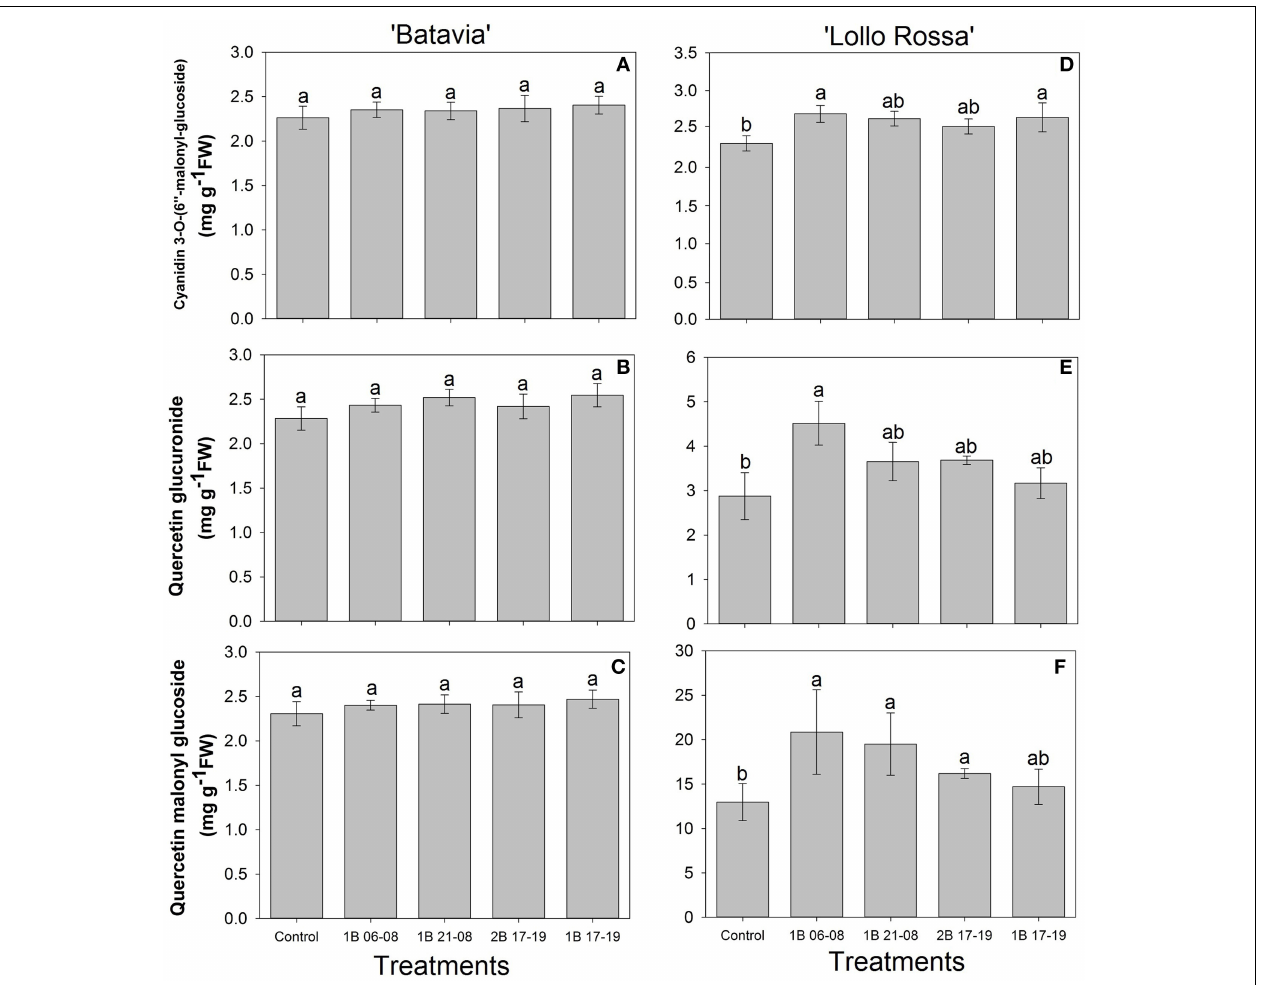
FIGURE 8 | Flavonoid content [cyanidin 3-O-(6 (cid:2)(cid:2) -malonyl-glucoside), quercetin glucuronide, quercetin malonyl glucoside] of Lactuca sativa “Batavia” (A–C) and “Lollo Rossa” (D–F) grown under the five different LED treatments with the same abbreviations as in Figure 2.